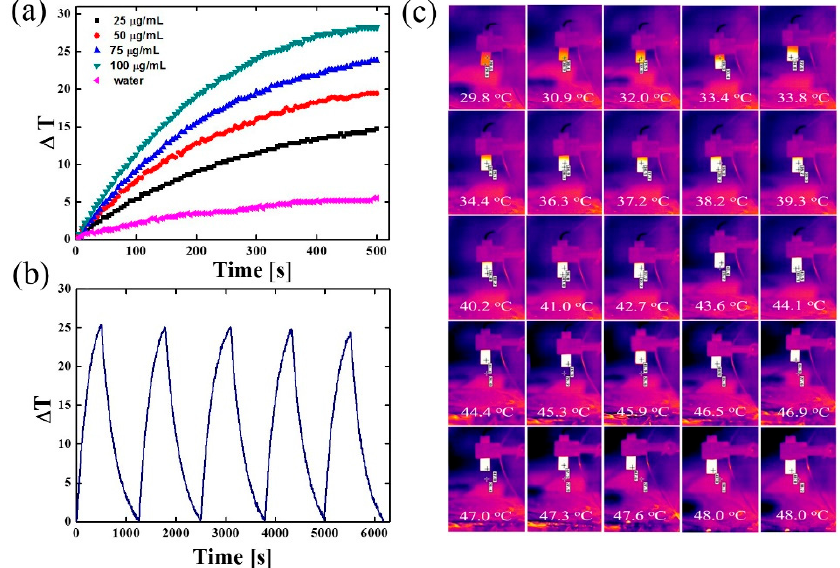
Figure 6. ( a ) Temperature change versus time, recorded for nanomaterial B at various concentrations; ( b ) Photostability of nanomaterial B at concentration 100 µg/mL under beam NIR of 2 W/cm 2 ; ( c ) Infrared thermal images of Fe 3 O 4 @PDA nanoparticles upon irradiation with NIR laser (808 nm, 2.0 W/cm 2 ). Time interval 20 s.